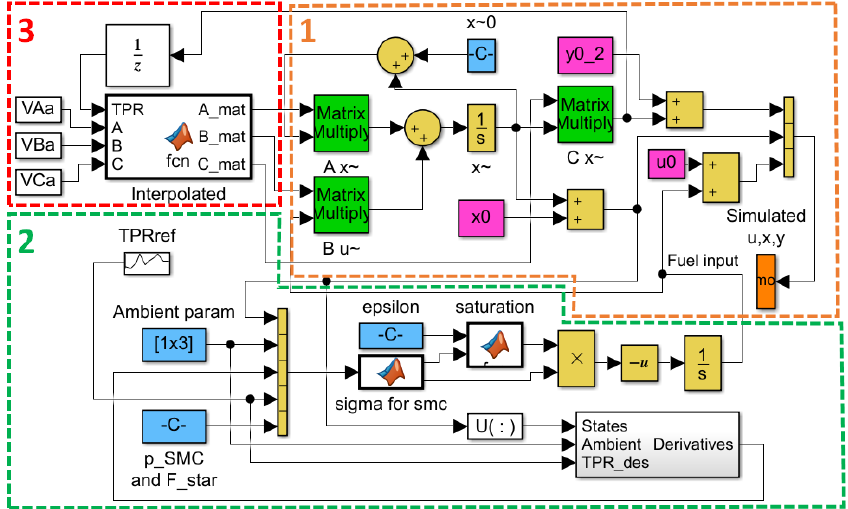
Figure 4. MATLAB Simulink software layout for SMC with